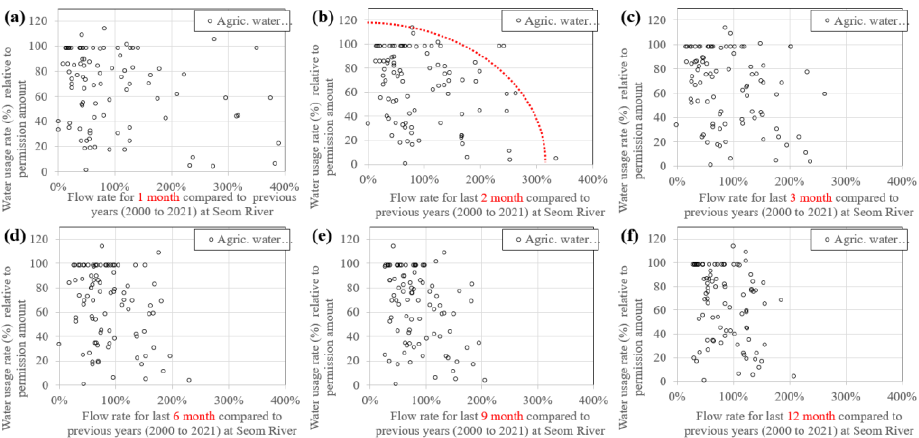
Figure 5. Scatter diagram for the percent of normal year for last several months versus water utilization rate compared to permission amount in the Seom River; ( a ) 1-month; ( b ) 2-months and red-dot-line indicate threshold curve of the URP; ( c ) 3-months; ( d ) 6-months; ( e ) 9-months; ( f ) 12-months.